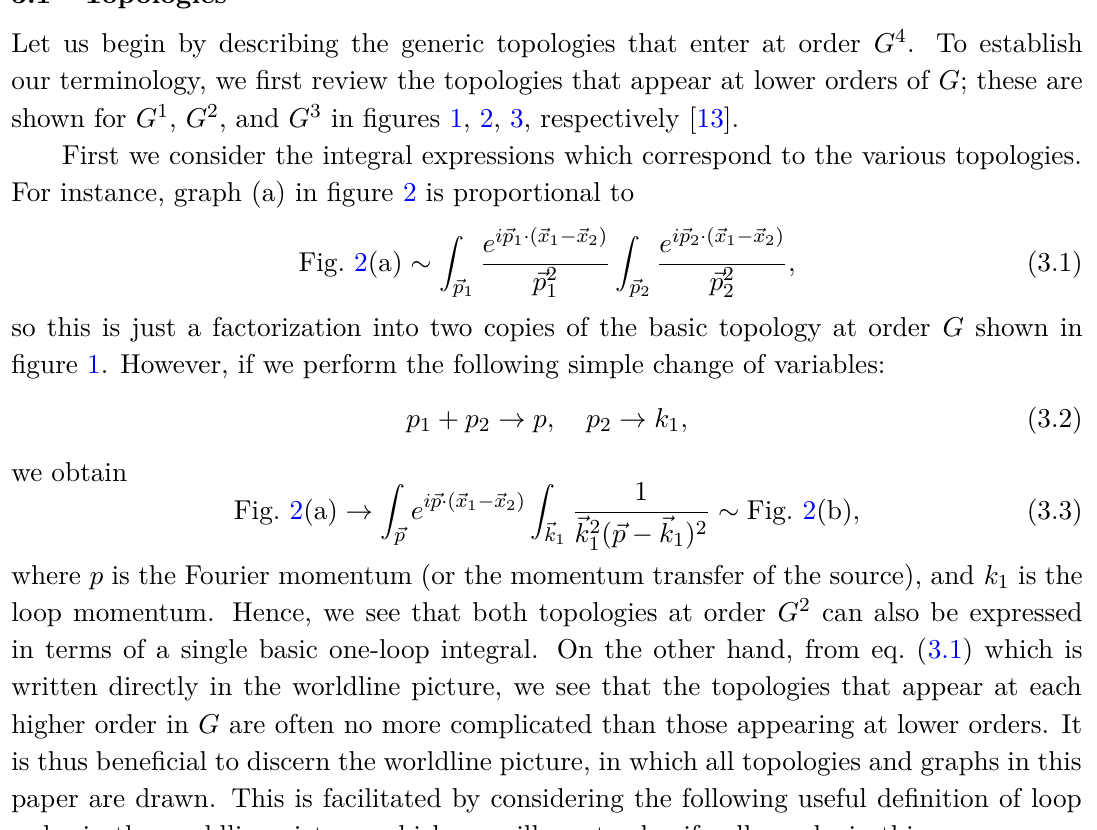
Figure 2 . Graph topologies at order G 2 : (a) No self-interaction vertices. (b) One cubic ver- tex. This is a one-loop topology in the worldline